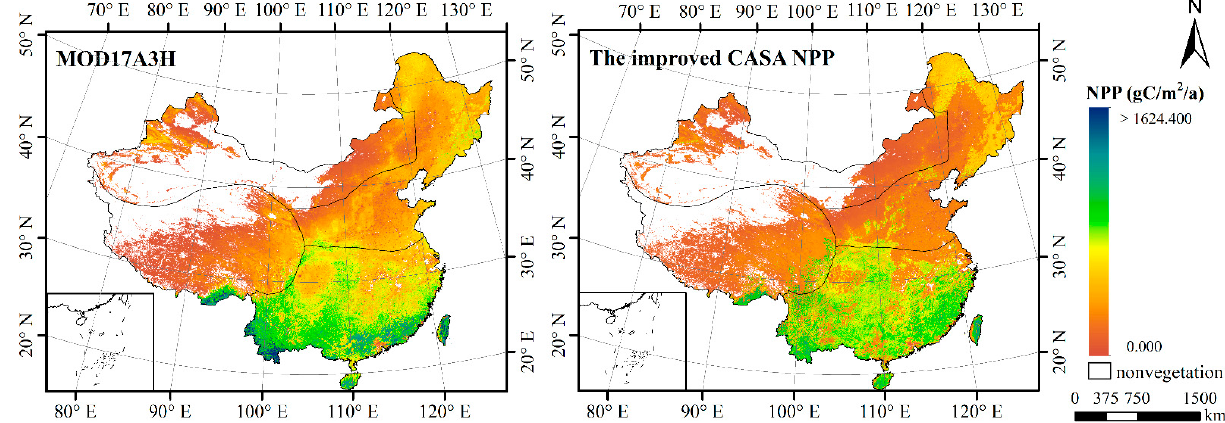
Figure 3. Comparison between MOD17A3H and the improved CASA NPP results. Table 3. Comparison of NPP mean values of different vegetation types based on MOD17A3H and optimized CASA